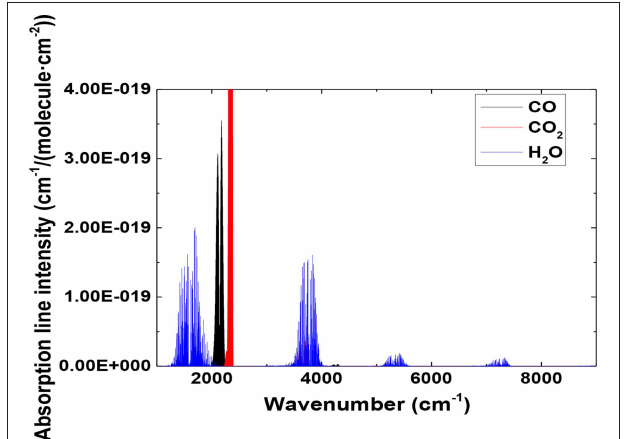
FIGURE 1 | Absorption band of three